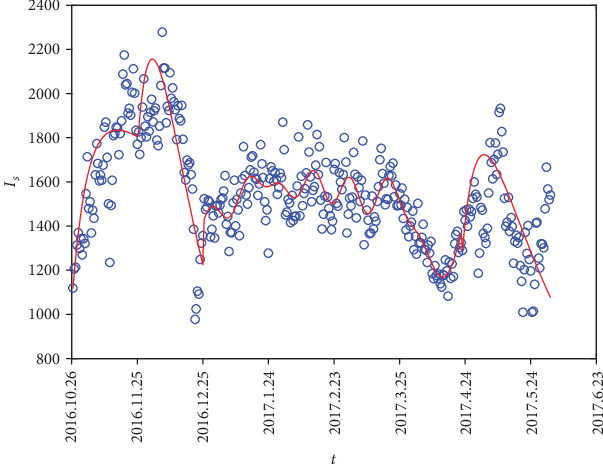
Fitting chart of Is from October 26, 2016, to October 25, 2017.